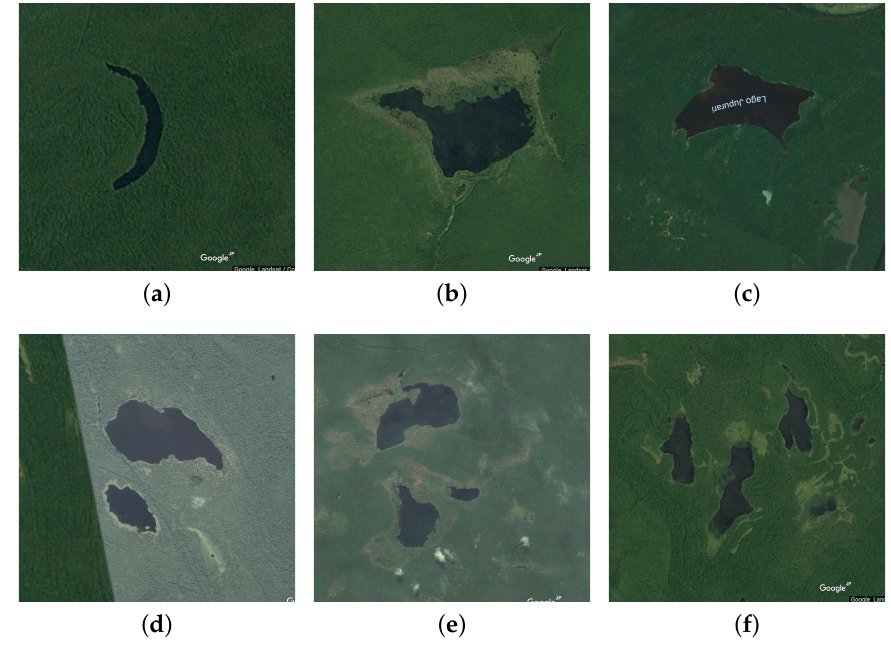
Figure 7. Real maps obtained from the Google Earth. The black regions represent the lakes [38].